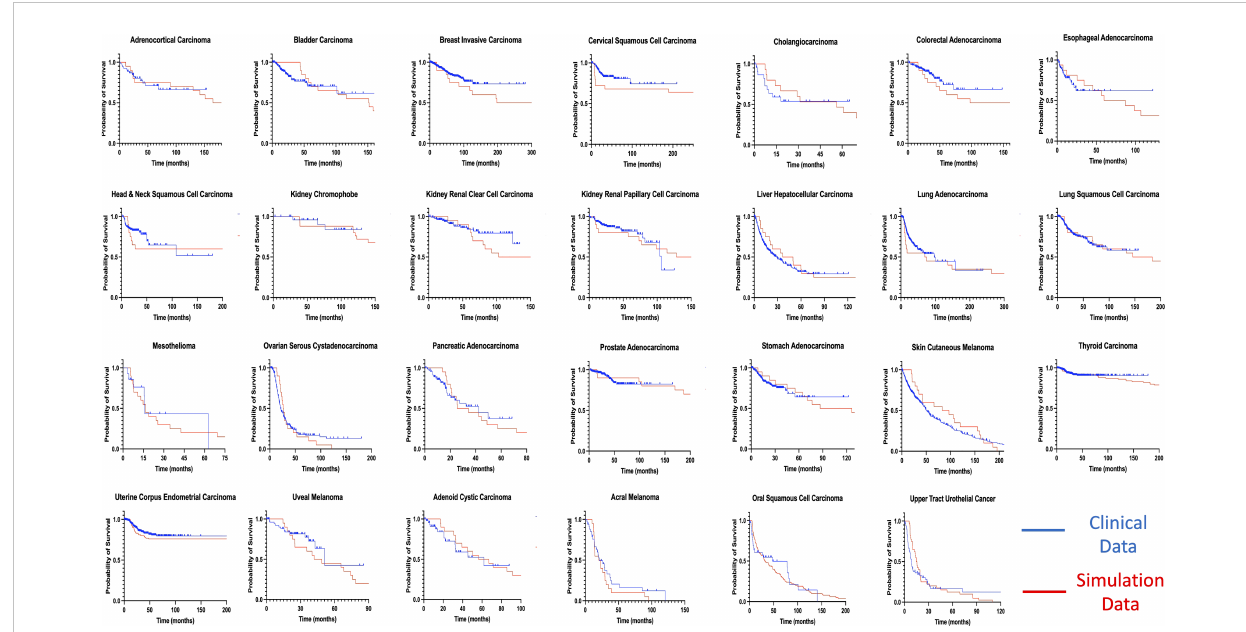
FIGURE 6 Fitting of model-derived in silico data to published clinical data for 27 cancer types. Thousands of stochastic runs were used to obtain parameter sets that best fi t survival curves of 27 non-sarcoma, non-hematologic cancer types. Blue curves indicate clinical data while red curves indicate simulation data survival curves. p values between curves are found in Table 1. ACC, Adrenocortical Carcinoma; BLCA, Bladder Urothelial Carcinoma; BRCA, Breast Invasive Carcinoma; CESC - Cervical Squamous Cell Carcinoma; CHOL – Cholangiocarcinoma; COAD, Colorectal Adenocarcinoma; ESCA, Esophageal Adenocarcinoma; HNSC, Head & Neck Squamous Cell Carcinoma; KICH, Kidney Chromophobe; KIRC, Kidney Renal Clear Cell Carcinoma; KIRP, Kidney Renal Papillary Cell Carcinoma; LIHC, Liver Hepatocellular Carcinoma; LUAD, Lung Adenocarcinoma; LUSC, Lung Squamous Cell Carcinoma; MESO – Mesothelioma; OV, Ovarian Serous Cystadenocarcinoma; PAAD, Pancreatic Adenocarcinoma; PRAD, Prostate Adenocarcinoma; STAD, Stomach Adenocarcinoma; THCA, Thyroid Carcinoma; UCEC, Uterine Corpus Endometrial Carcinoma; UVM, Uveal Melanoma; ACYC, Adenoid Cystic Carcinoma; MEL, Acral Melanoma; UTUC, Upper Tract Urothelial Cancer; OSCC, Oral Squamous Cell Carcinoma; SKCM, Skin Cutaneous